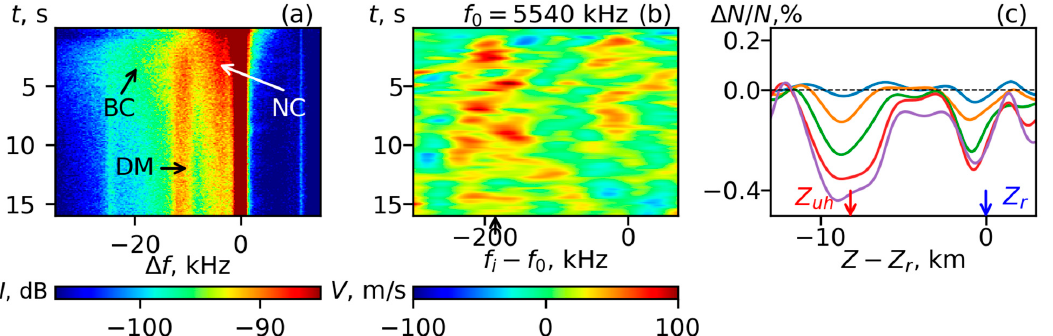
Figure 5. Panel ( a ): SEE spectrograms for f 0 = 5540 kHz for 0 < t < 16 s (a part of the Figure 1c, 1st row). Panel ( b ): Velocity of the sounding waves reflection height displacement V v = ∂Δ z r ( f i , t )/ ∂ t vs. time and frequency for f 0 = 5540 kHz for 0 < t < 16 s (a part of the Figure 2b, 1st row). Panel ( c ): Relative variations of electron density [ N ( t ) − N (0)]/ N (0) vs. height at t = 1.5 s (blue), 4 s (orange) 8 s (green), 12 s (red) and 16 s (pink) in the same cycle.